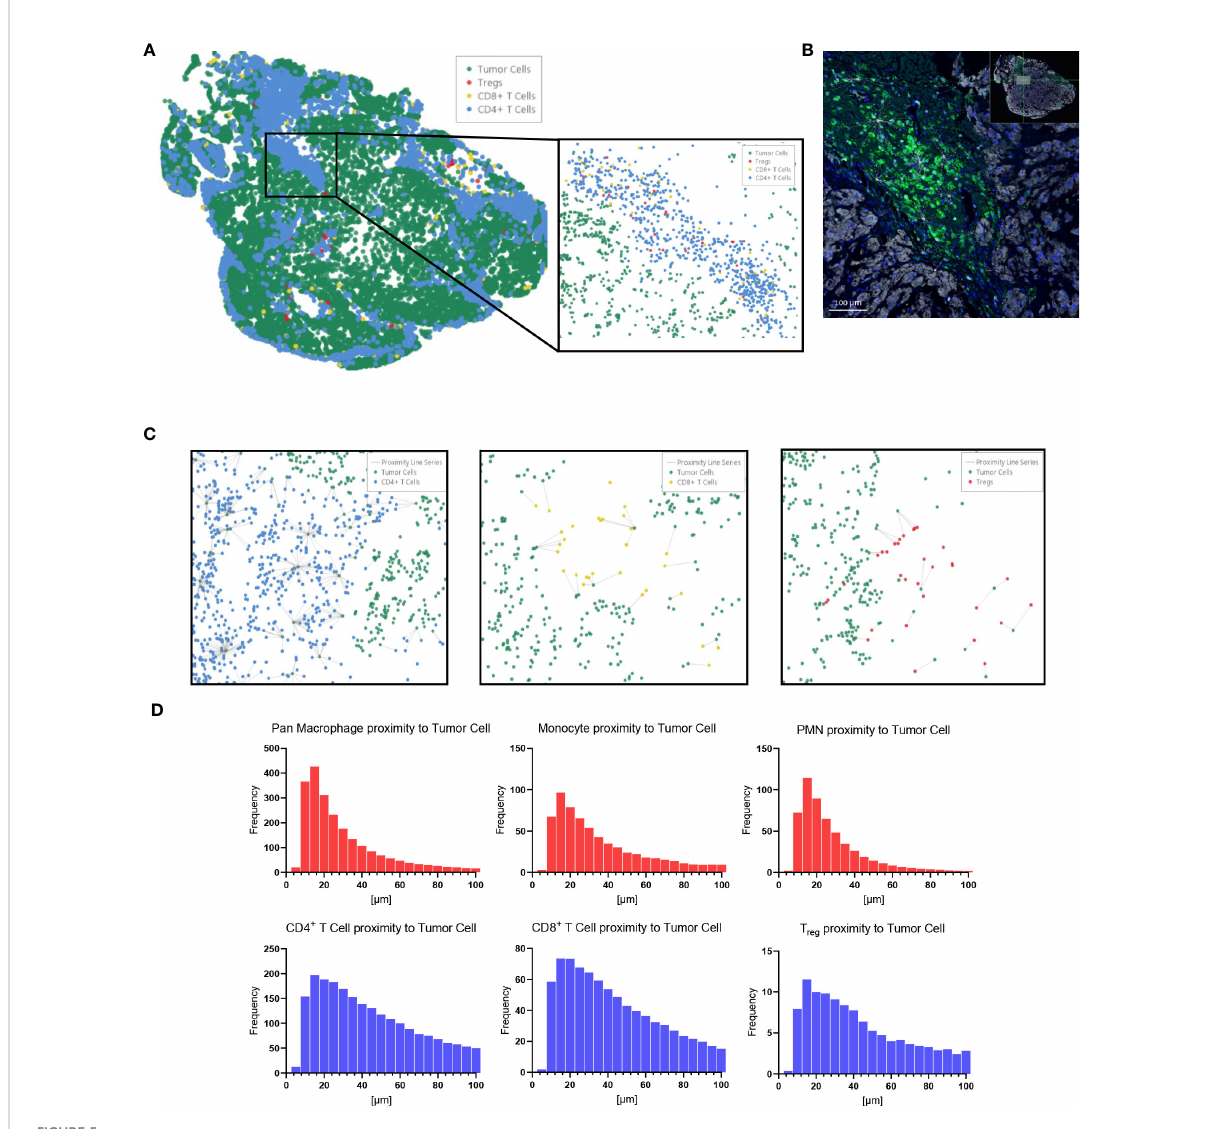
FIGURE 5 HALO ® spatial proximity analyses of immune cells to chordoma cells demonstrate that T cells are nearer than myeloid cells to tumor cells. (A) Sacral chordoma specimen with three categories of T cells, CD4 + T cells, CD8 + T cells, and T regs shown in blue, yellow, and red respectively. Tumor cells are shown in green. A segment of heavy T cell in fi ltrate is magni fi ed. (B) Real time proximity analysis between CD4 + T cells (green, Opal 520) and chordoma cells (white, Opal 780) with bars measuring distance between these superimposed on the image in white. (C) Proximity line series between T cells and chordoma tumor cells. (D) Proximity analysis histograms of myeloid cells (top row, red) and T cells (bottom row, blue) to chordoma tumor cells within a 100µm radius by progressive segments of 20µm bands (n = 56 individual